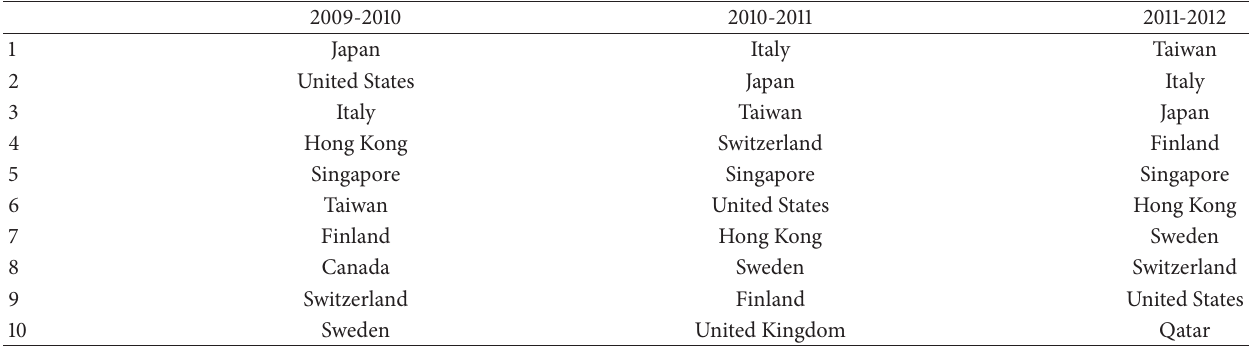
Table 2: Rank of industrial clusters.